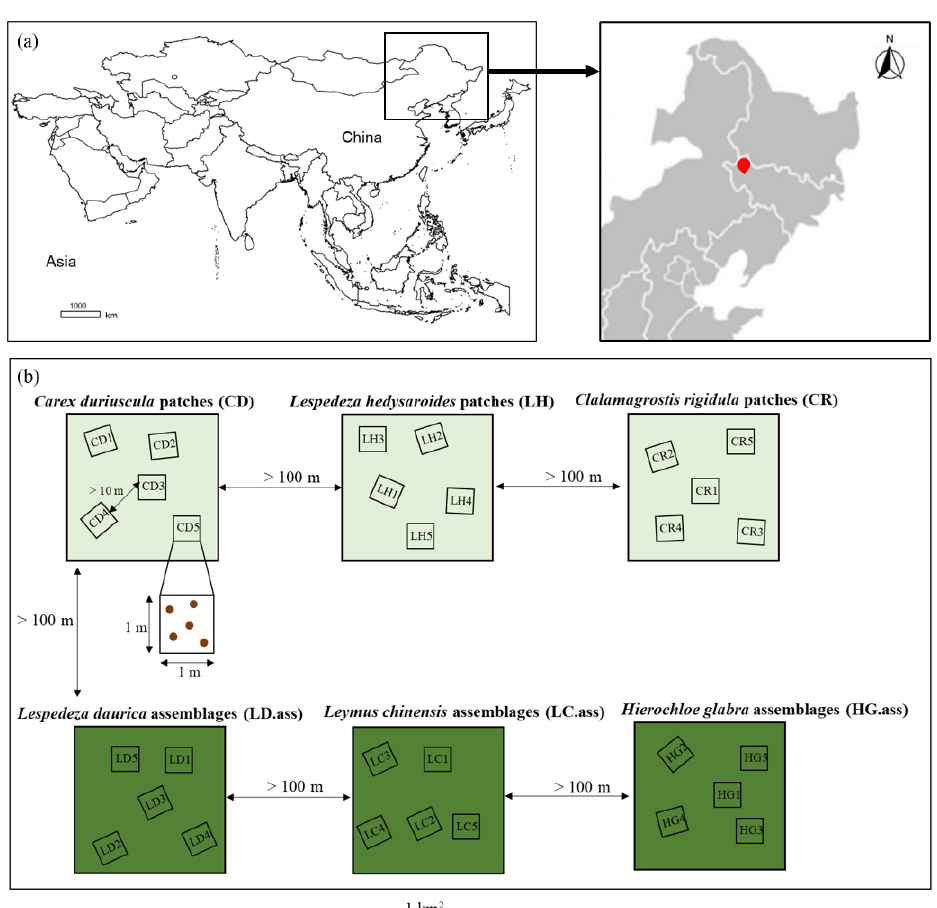
Figure 1. Locations of the study site ( a ) and experimental design for plant and soil sampling ( b ) in the Songnen grassland, China. Three single plant species patches, i.e., Carex duriuscula C.A.Mey. (CD), Lespedeza hedysaroides (Pall.) Kitag. (LH), and Calamagrostis rigidula A.I.Baranov and Skvortsov (CR) assemblages and three multiple species coexisting plant assemblages with different dominant Lespedeza daurica (Laxm.) Schindl. (LD.ass), Leymus chinensis (Trin.) Tzvelev (LC.ass), and Hierochloe glabra Trin. (HG.ass) naturally existing in the grassland. For the six study sites selected above, the interval between every two sites was greater than 100 m. For plant and soil sampling, five plots (1 m × 1 m) with an interval of more than 10 m were randomly selected at each study site. Five soil cores were randomly selected in each plot by a soil auger.